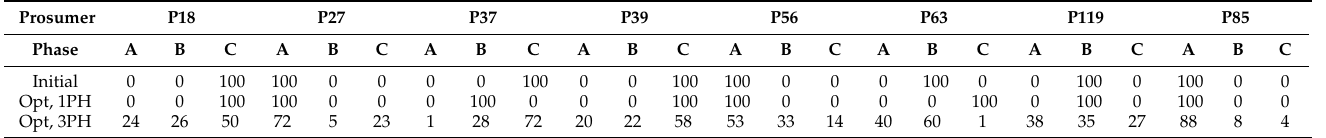
Table 6. Surplus redistribution solutions for network R121, in percent. Table 7. Prosumer surplus shifting on the three phases in network R121.